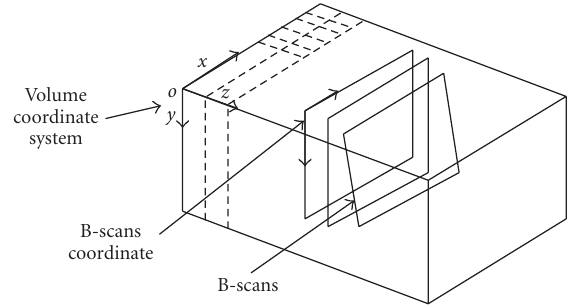
Figure 1: Illustration of 3D volume reconstruction from 2D free- hand B-scans.